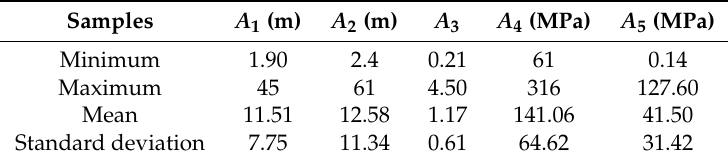
Table 2. Descriptive statistics of each